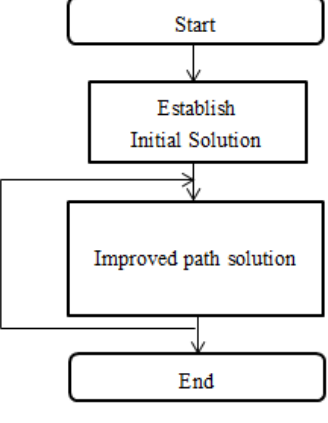
Figure 1. Main flow chart.